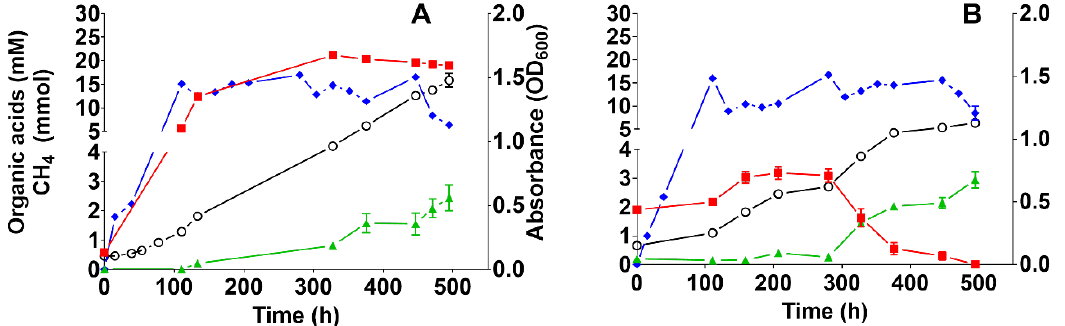
Figure 5. Effect of the reducing agent on the anaerobic conversion of H 2 /CO 2 (80:20; fed-batch) in 1-L bioreactors following shaking at 200 rpm. ( A ) Medium B (mineral medium free of yeast extract, supplemented with vitamins and reduced with cysteine-HCl), and ( B ) medium C (prepared as medium B but containing sodium sulfide instead of cysteine-HCl as reducing agent; see Section 2.2). The experiments were conducted with two biological replicates and each data point depicts the median and range. Red square: acetic acid (mM), green triangle: formic acid (mM), blue diamond: CH 4 (mmol), and black open circle: biomass.